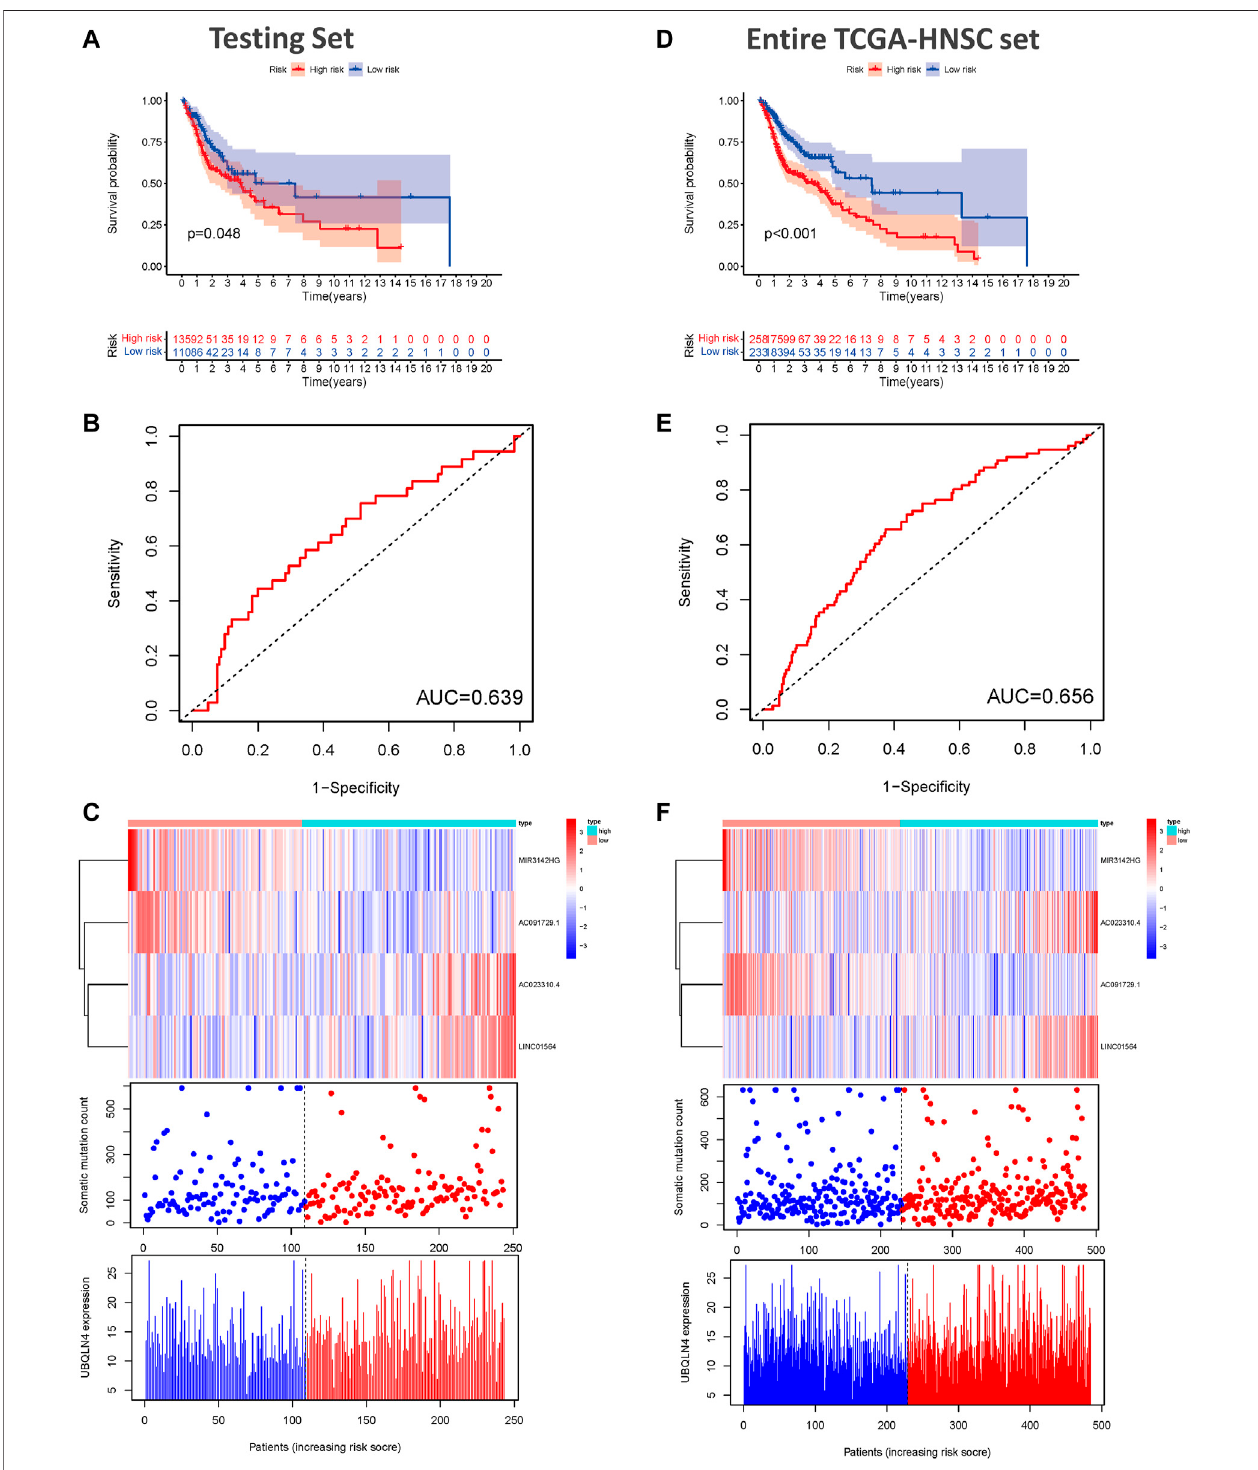
FIGURE 4 | Validation of the predictive performance of the genome instability-related lncRNAs signature in the testing and TCGA sets. (A) Kaplan-Meier survival curves for HNSCC patients in the high- and low-risk groups grouped by the GILncSig score in the testing set. (B) Time-independent receiver operating characteristic curves of the GILncSig in the testing set. (C) lncRNA expression patterns and the distributions of somatic mutation and UBQLN4 expression with increasing GILncSig score in the testing set. (D) Kaplan-Meier survival curves for HNSCC patients in the high- and low-risk groups grouped by the GILncSig score in the entire TCGA- HNSC set. (E) Time-independent receiver operating characteristic curves of the GILncSig in the entire TCGA-HNSC set. (F) LncRNA expression patterns and the distributions of somatic mutation and UBQLN4 expression with increasing GILncSig score in the entire TCGA-HNSC set. GILncSig, genomic instability-associated lncRNAs signature; HNSCC, head and neck squamous cell carcinoma.